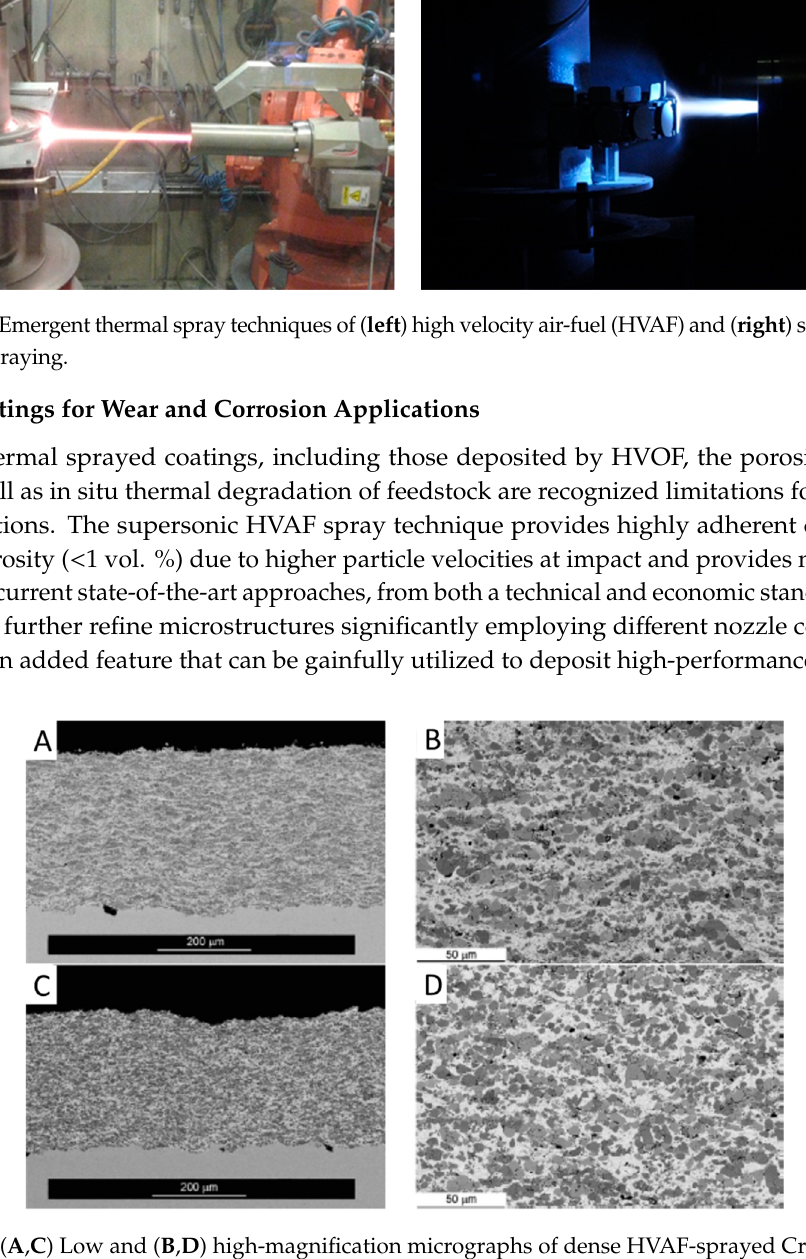
Figure 2. ( A , C ) Low and ( B , D ) high-magnification micrographs of dense HVAF-sprayed Cr 3 C 2 –NiCr coatings, illustrating the ability to refine microstructures by varying nozzle configuration. (A,B): M3; (C,D): M2 [23].